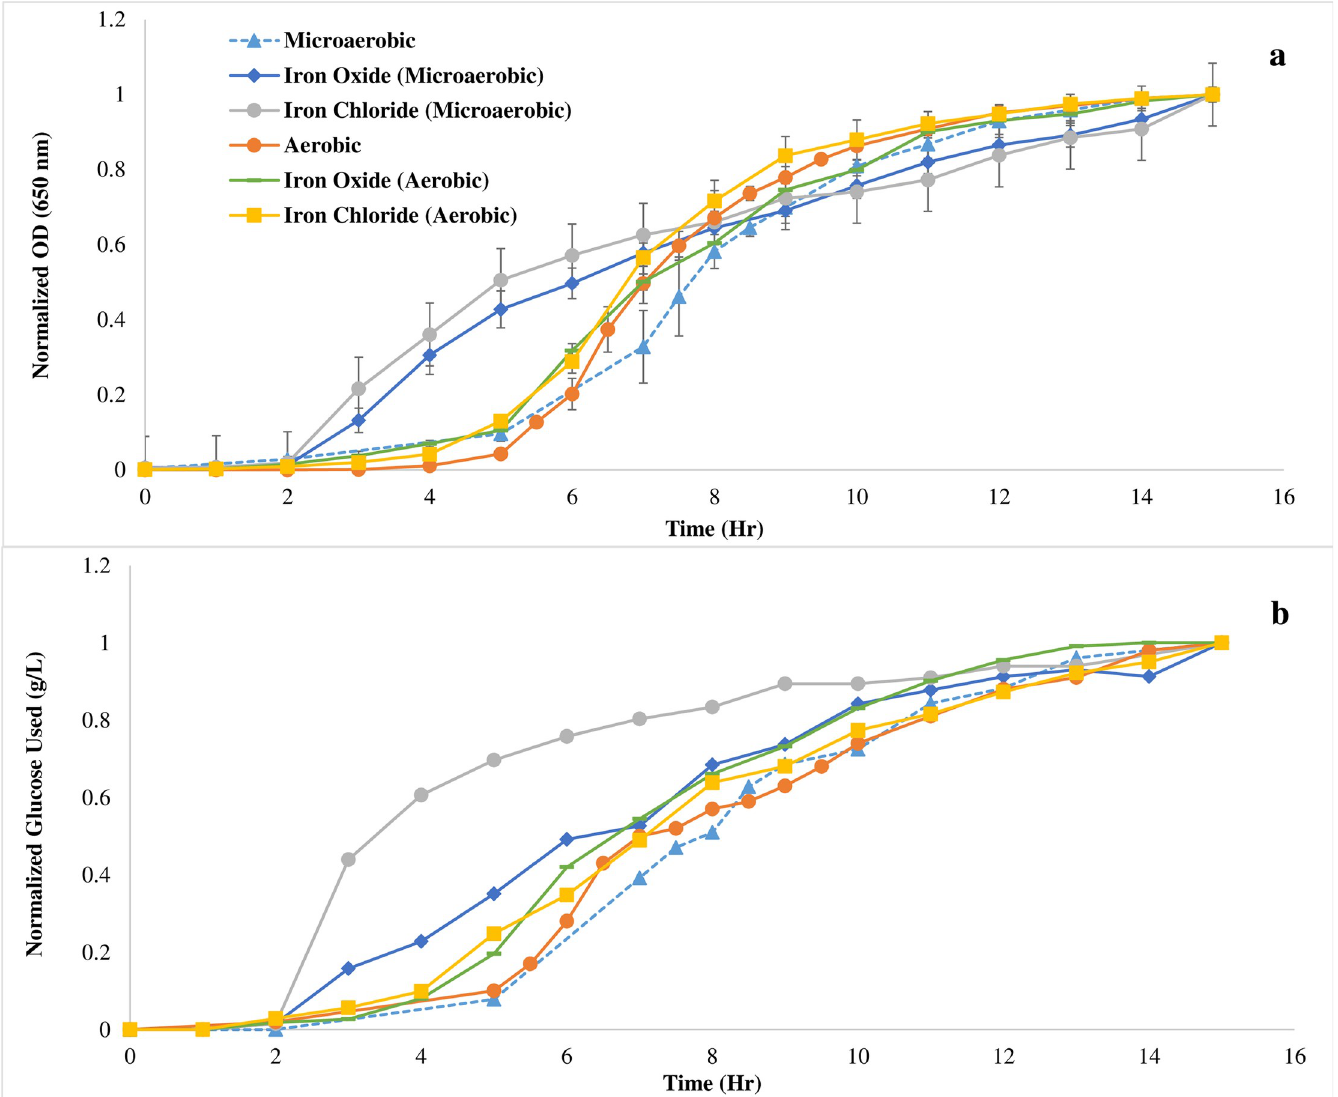
Fig 5. Normalized results for a) optical density and b) glucose usage. The onset of exponential growth appears sooner for microaerobic samples containing ferric iron in the growth media, which also correlates to the time at which glucose utilization becomes more rapid.